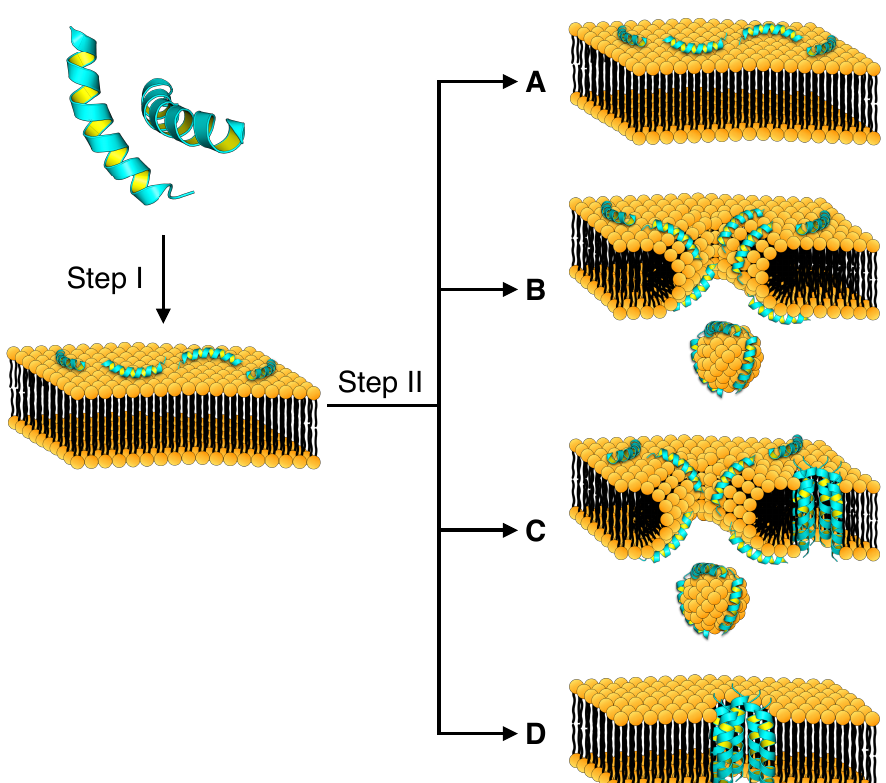
Figure 2. Membrane interaction schematic of diastereomer and all- L peptides with zwitterionic and negatively-charged membranes. Step I: both types of HDP bind to membranes via the electrostatic force, and in the case of all- L peptides, a hydrophobic interaction is also present. Step II: increasing the peptide concentration will result in different outcomes depending on the peptide and membrane type. ( A ) Diastereomer interaction with a zwitterionic phosphatidylcholine and cholesterol (PC/Cho) membrane. The peptide remains at the surface and does not disrupt the membrane structure significantly; ( B ) The carpet mechanism, the primary diastereomer interaction pathway with the negative phosphatidylethanolamine and phosphatidylglycerol (PE/PG) membrane. A large number of the peptides engulf the membrane like a carpet, and their amphipathicity induces micellization. Toroidal pores may also be formed; ( C ) Partial carpet mechanism, the primary interaction mechanism of all- L host defense peptides (HDPs). This mechanism can occur when disrupting both negative and neutral membranes. Both the carpet and membrane pore disruption mechanisms occur. The partial carpet mechanism is also employed by strong hemolytic peptides, such as pardaxin, during the disruption of negative PE/PG membranes; ( D ) Barrel-stave mechanism, the mechanism employed by strong hemolytic HDPs, such as pardaxin, for the disruption of zwitterionic PC/Cho membranes. The peptides insert deep into the hydrophobic core of the membrane and form well-defined trans-membrane ion channel, with the peptide hydrophobic face facing the membrane hydrophobic core and the polar face facing inward. Adapted with permission from [49]. Copyright (2004) American Chemical